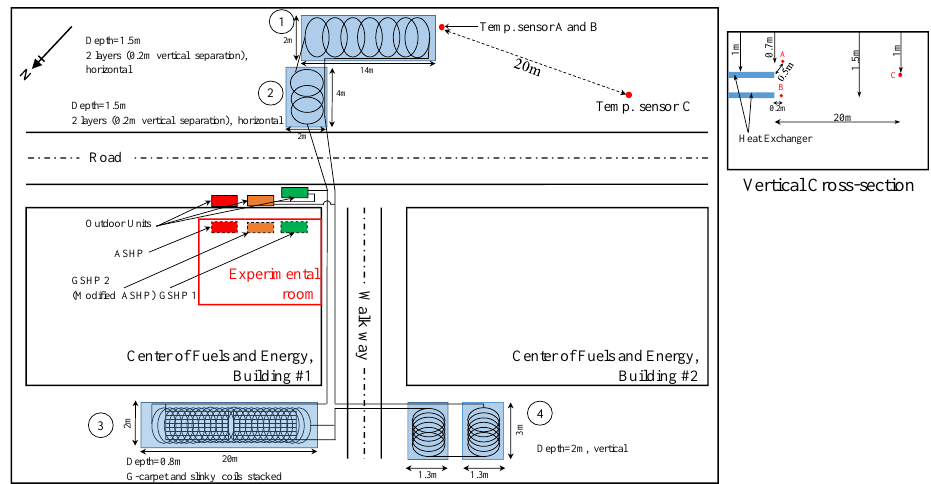
Figure 3. Schematic diagram of the connection of heat pumps and GHEs; the number in the circle represents the grouping of the ground heat exchangers.